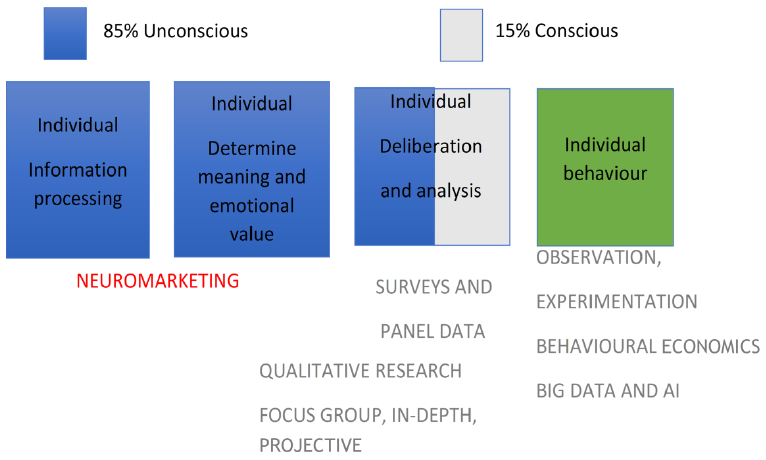
Figure 2. Research techniques and mental process involved. Source: adapted from